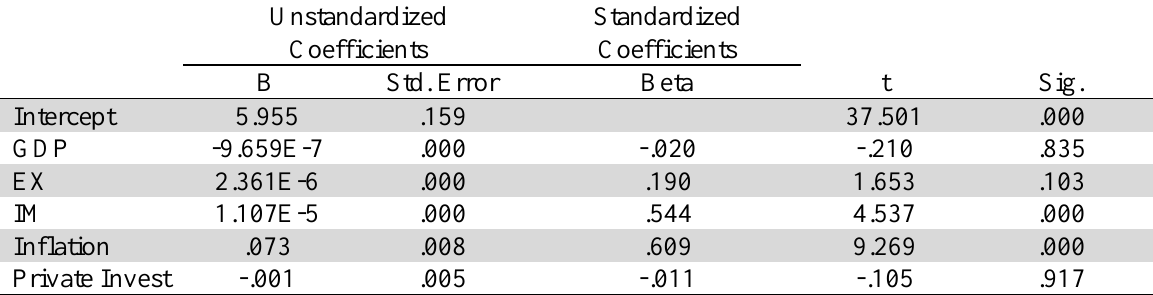
The results of regression